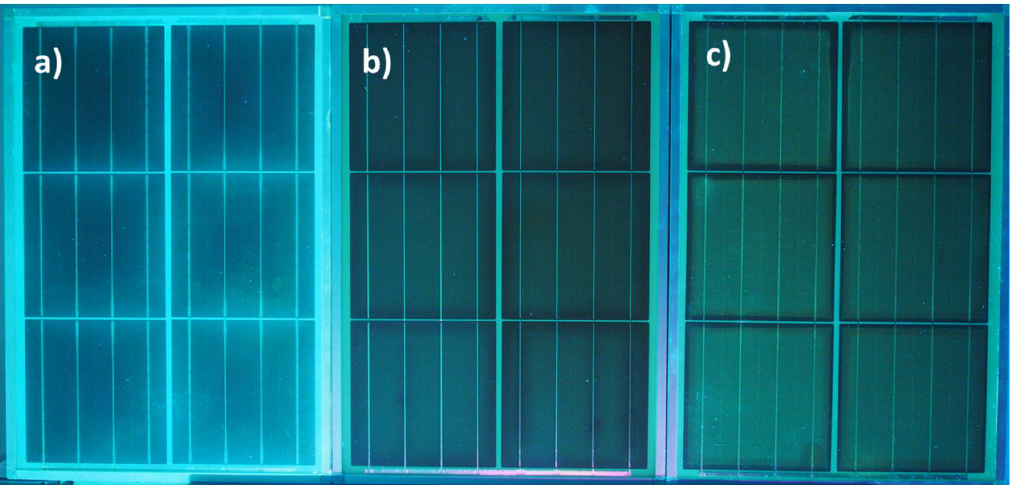
Figure 7. UV-F images of three test modules with interconnector defects: ( a ) one after DH storage for 2000 h; ( b ) one after natural weathering outdoors for 1.5 years; and ( c ) one after indoor exposition to artificial sunlight (1000 W/m 2 ) for 1000 h.